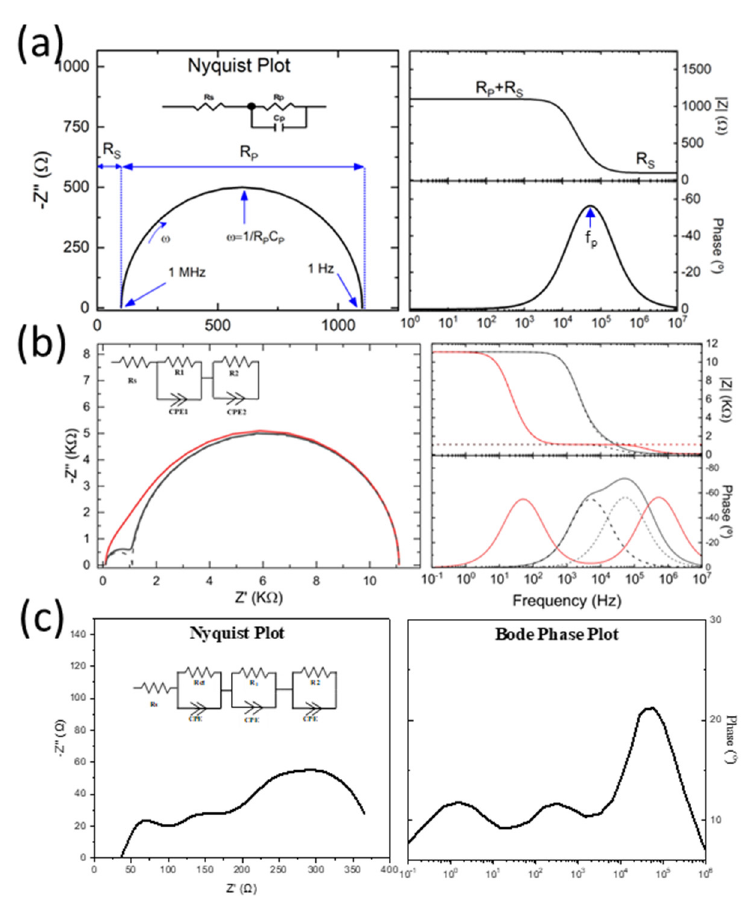
Figure 4. Representation of Impedance spectra using Nyquist plots (left) and Bode plots (right): ( a ) 1-RC circuit; ( b ) 2-RC circuit, black lines represent the Nyquist and Bode plots with well-separated arcs while the red lines symbolize the merged arcs (Reproduced with permission from [59]. Society of Photo-Optical Instrumentation Engineers, 2019.); and ( c ) 3-RC circuit. The corresponding RC circuit diagrams can be found in the inset of Nyquist